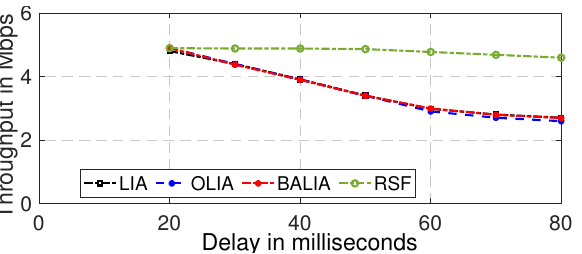
Figure 6. Throughput results for a 10 MB file transfer in Scenario 5: heterogeneous delay paths. One path had 20 ms delay, while the delay of the other one was varied. Both paths had 20 Mbps bandwidth and 3% random packet